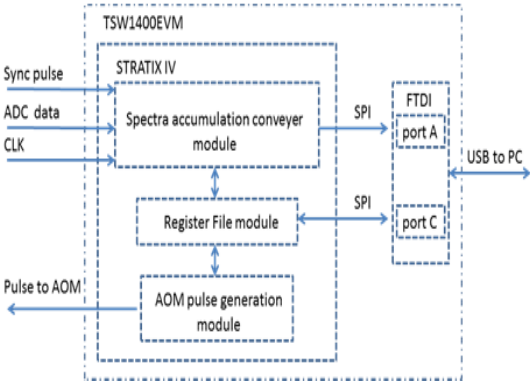
Fig.2. Software-hardware data processing system block diagram.